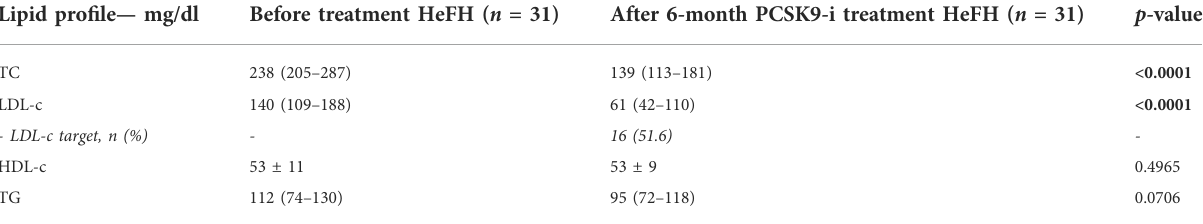
TABLE 2 Lipid pro fi le characteristics of study population at baseline and after 6 months of PCSK9-i treatment.